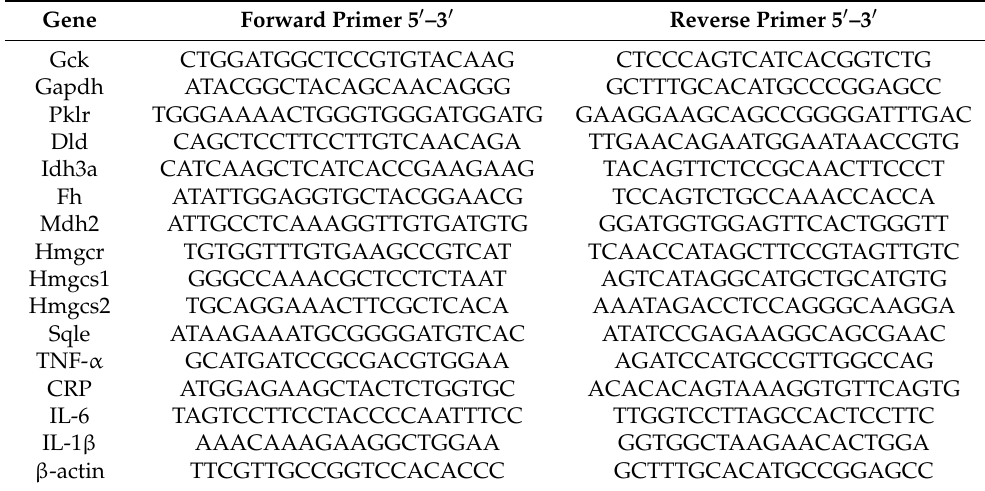
Table 1. Quantitative real-time PCR primer